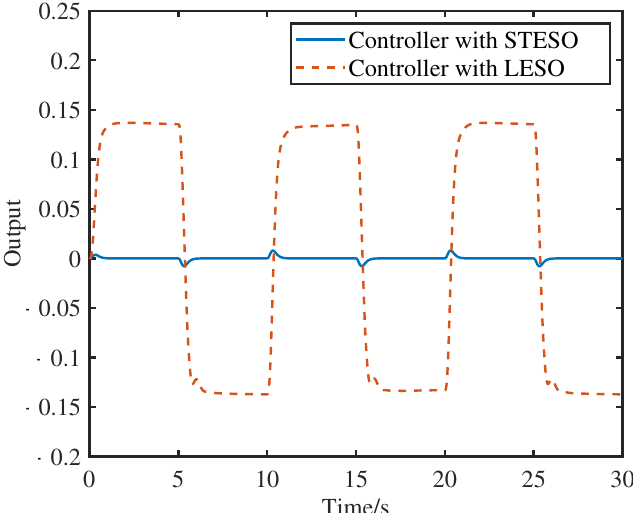
Figure 5. Simulation resultsof multiple disturbance—system out: controller with STESO (solid line); controller with LESO (dashed line).